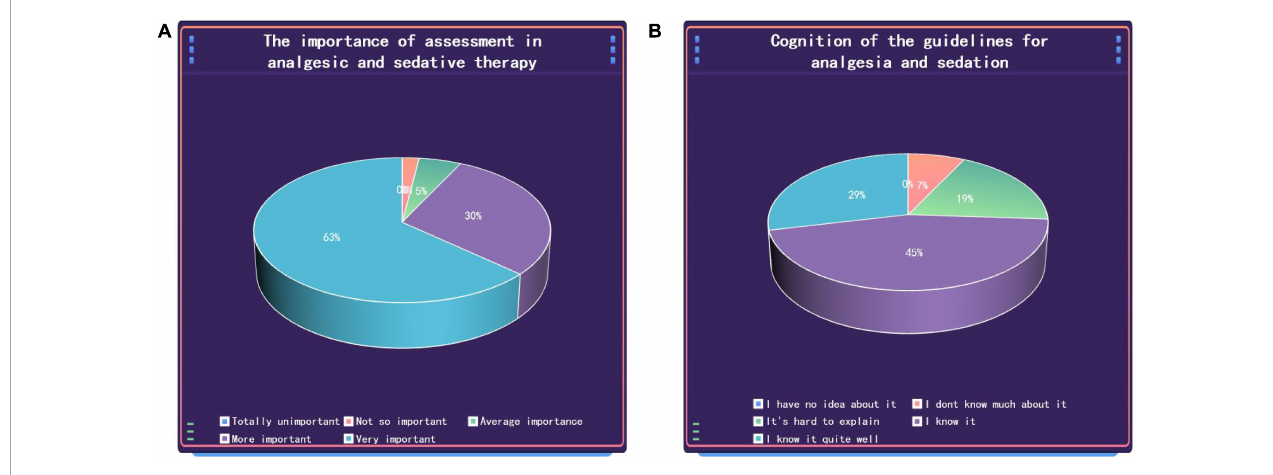
FIGURE1 Medical staff’s understanding of the importance of sedation and analgesia assessment scales (A) and related guidelines (B) .